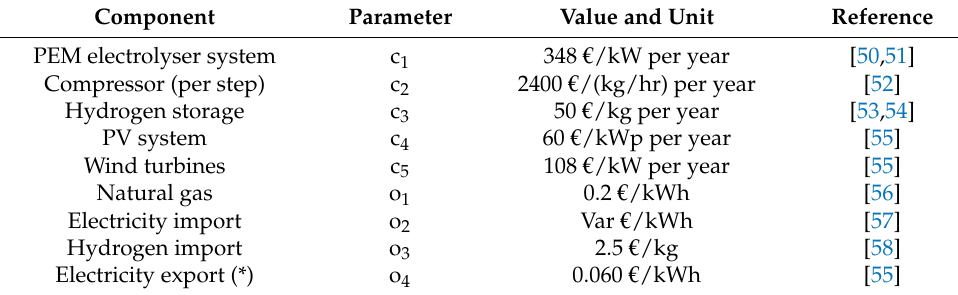
Table 3. Case related values for cost parameters.